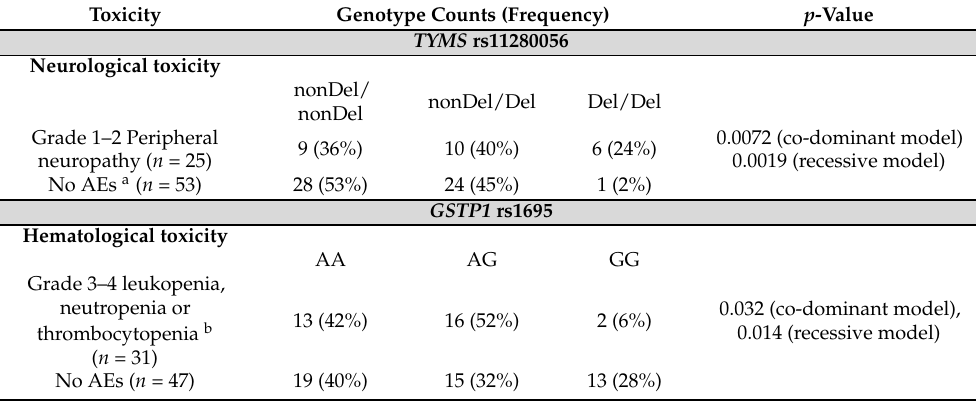
Table 3. TYMS rs11280056 and GSTP1 rs1695 genotype frequencies identified in PDAC patients treated with FOLFIRINOX ( n =